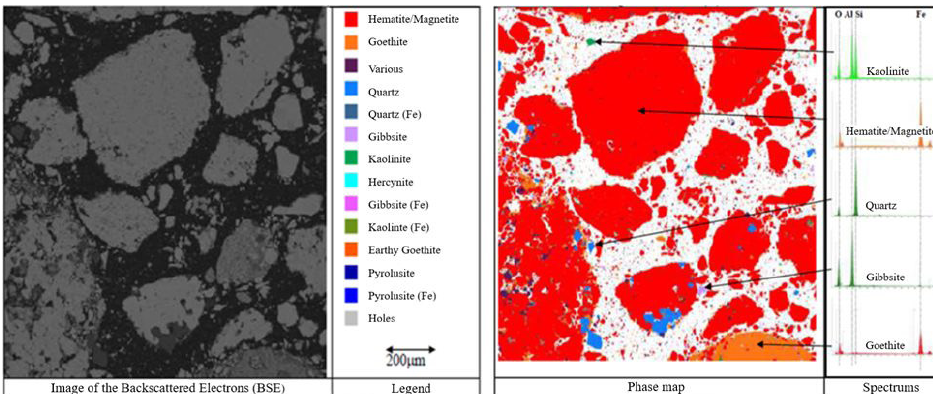
Figure 1. Stage of identification of mineral phases.